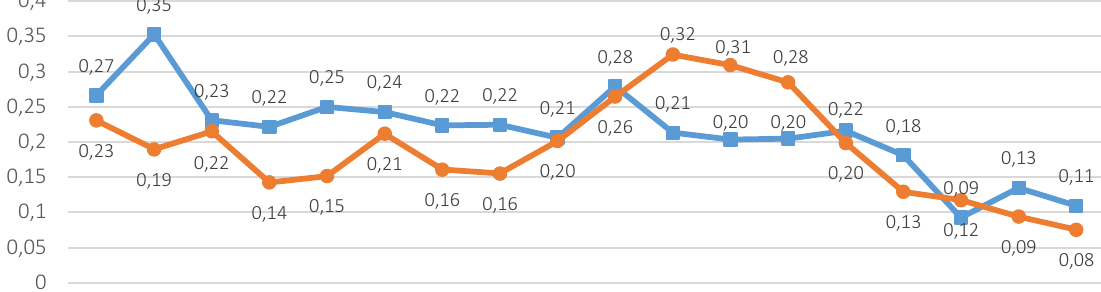
Figure 12. The dynamics of the integral index of the financial state of the shipping companies and shipyards in a period